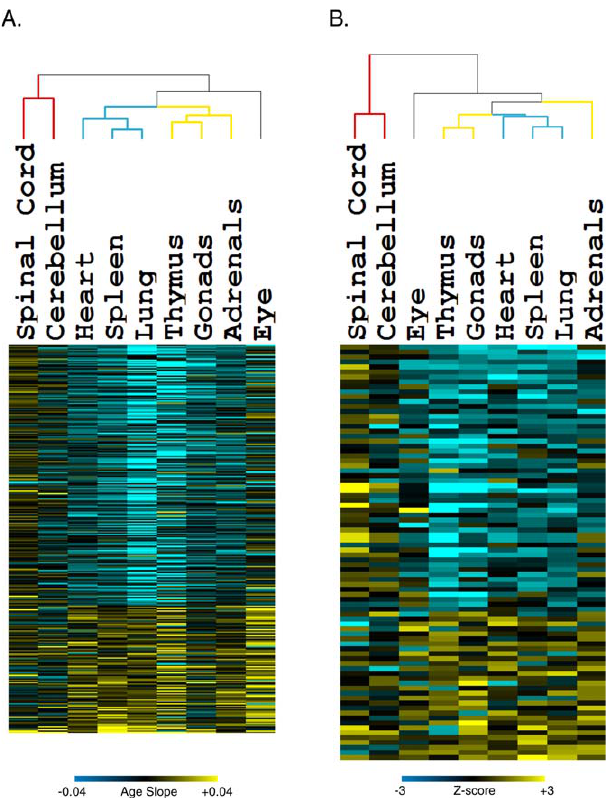
Figure 1. Genes and Gene Sets That Are Commonly Age Regulated in Multiple Tissues (A) Rows indicate individual genes, arranged from the gene that exhibits the greatest increase in expression with age across multiple tissues at top, to the gene that shows the greatest decrease in expression with age in multiple tissues at bottom. Each column corresponds to an individual mouse tissue. Scale corresponds to the slope of the change in log2 expression with age ( b 1j ). Dendrogram colors indicate affiliation with either the neural (red), vascular (blue), or steroid-responsive (yellow) tissue groups. (B) Rows indicate individual gene sets, arranged from the gene set increasing expression most on average with age in multiple tissues at top, to the most decreasing with age. Each column corresponds to an individual mouse tissue. Scale is the van der Waerden Z -value as determined by gene set enrichment analysis. Dendrogram colors indicate affiliation with either the neural (red), vascular (blue), or steroid-responsive (yellow) tissue groups. A navigable version of this figure exists at http://cmgm.stanford.edu/ ; kimlab/aging_mouse.doi:10.